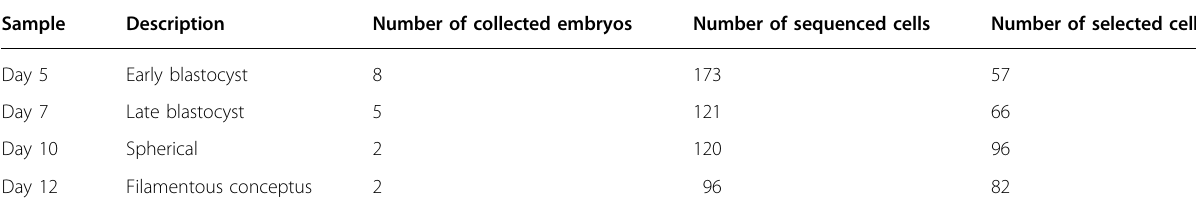
Table 1 Statistics of embryos and cells used in this